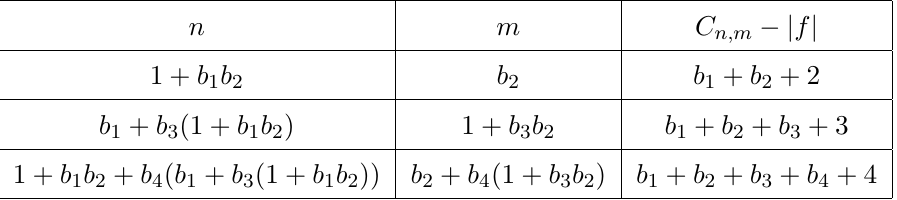
Table 1. The topological complexity (3.10) for the particular torus knots K n;m for which the regular continued fraction decomposition of n has up to 4 coe(cid:14)cients. The construction proceeds m similarly for r > 4. Recall that, according to our convention, b i (cid:21) 1 for i = 1 ; : : : ; r (cid:0) 1 while b r is strictly > 1.